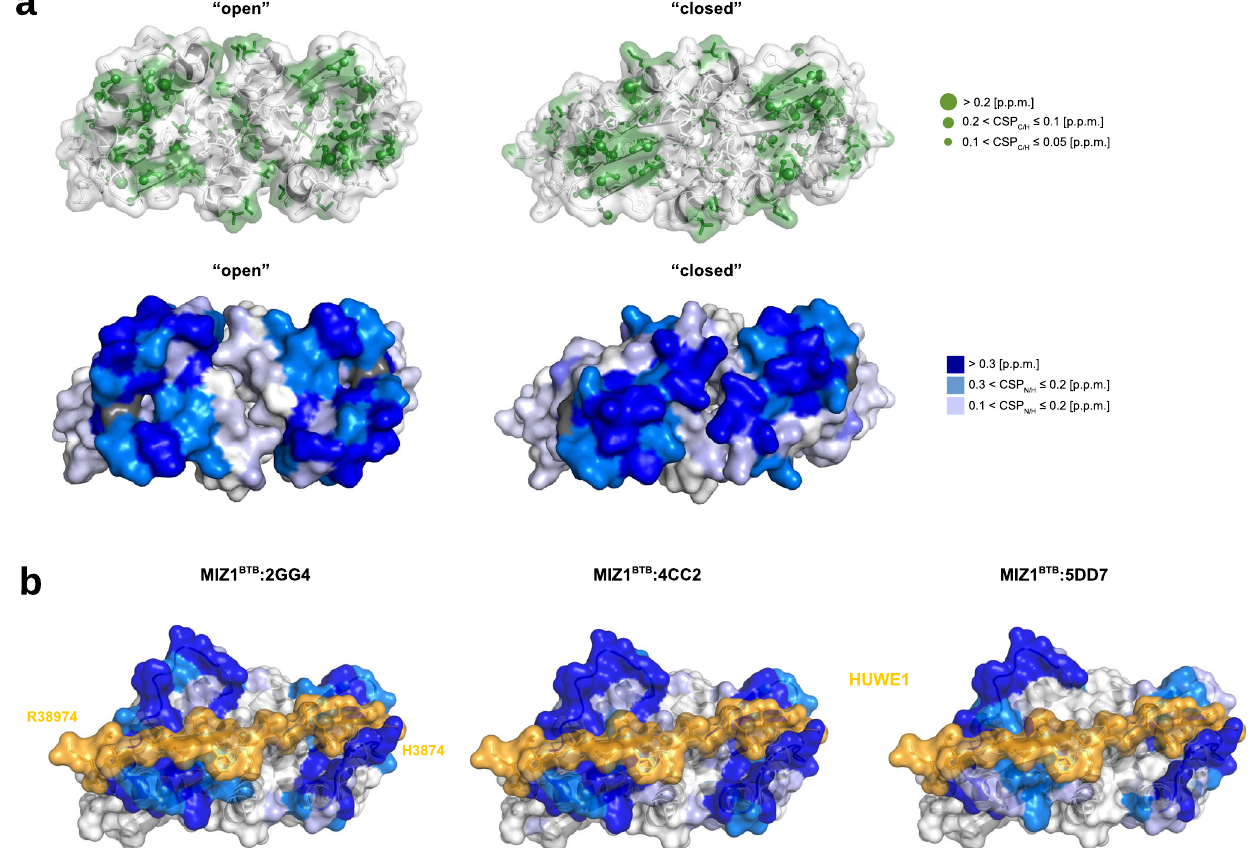
Fig. 2 | Ligands bind to the conformationally variable site on BTB domain. a Mapping of the chemical shift perturbations of methyl groups (upper row) and backbone amides (lower row) resulting from the binding of 2GG4 to MIZ1 BTB . The crystalstructureisshown in “ open ” (PDBid: 2Q81:A) and “ closed ” (PDB id: 2Q81:B) conformations. All methyl-containing residues (ILVAMT) are shown in green with sphere radii corresponding to the magnitude of chemical shift perturbation.